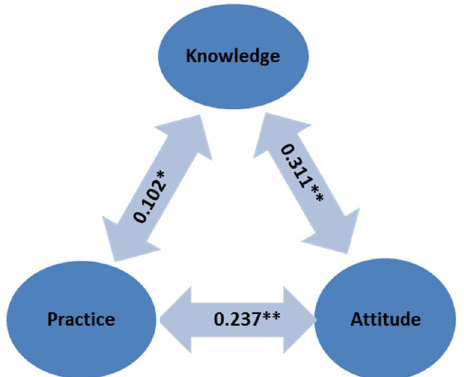
Figure 1. Pearson’s correlation analysis of the KAP constructs. Values in the double head arrows are the Pearson’s correlation coefficients (r). ** Correlation was significant at the 0.01 level (2-tailed). * Correlation was significant at the 0.05 level (2-tailed).